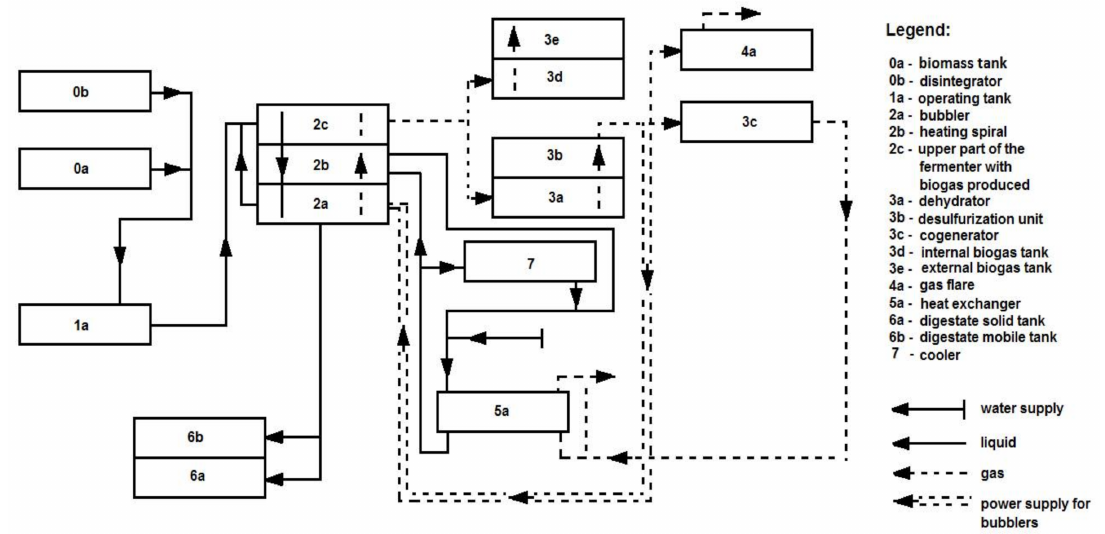
Figure 5. Biogas production prototype installation-block diagram of the test stand (source: own